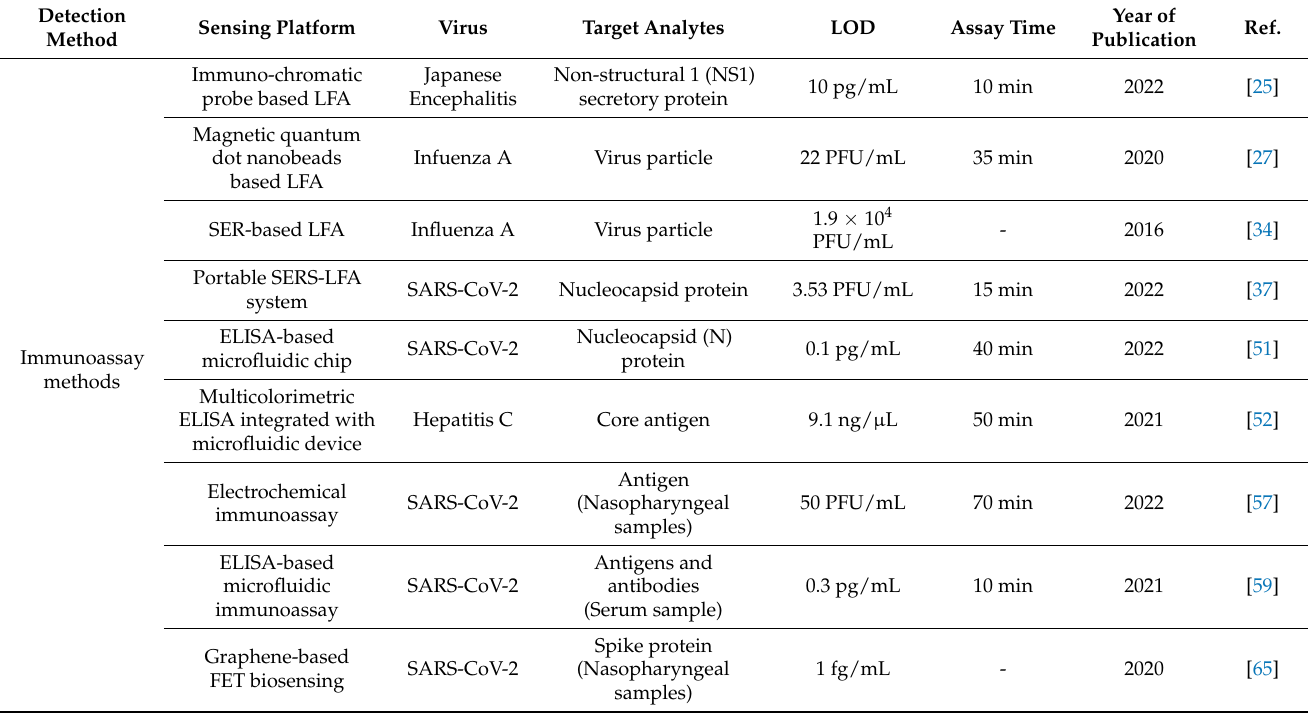
Table 3. An overview of molecular and immunological diagnostic platforms for virus